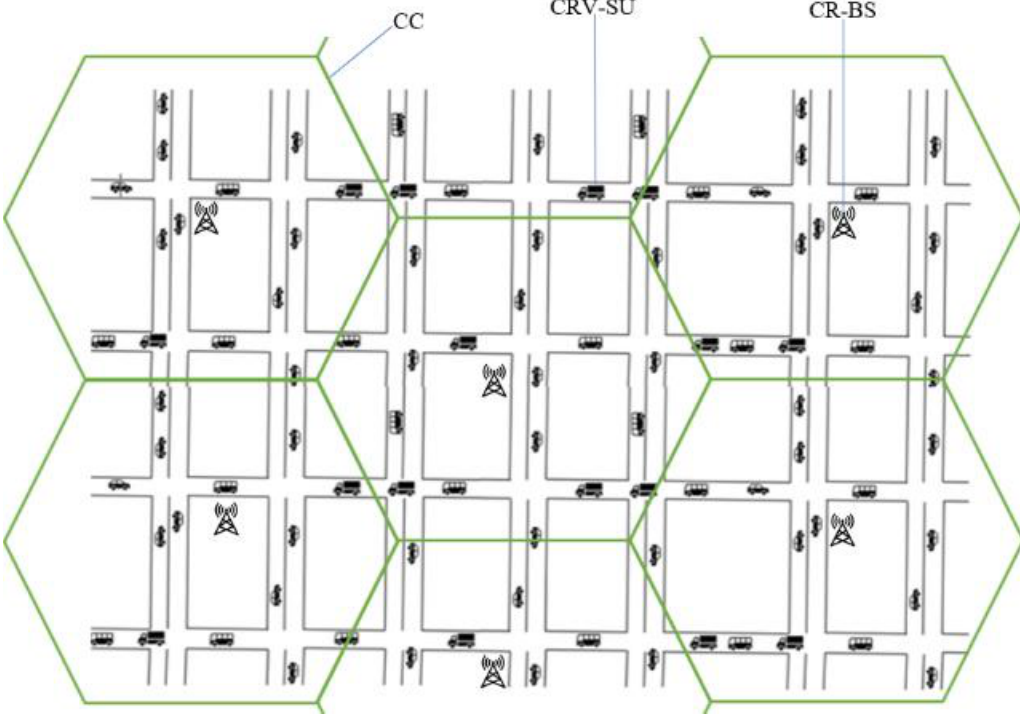
Figure 1. Illustration of a typical cognitive cell (CC) service area.